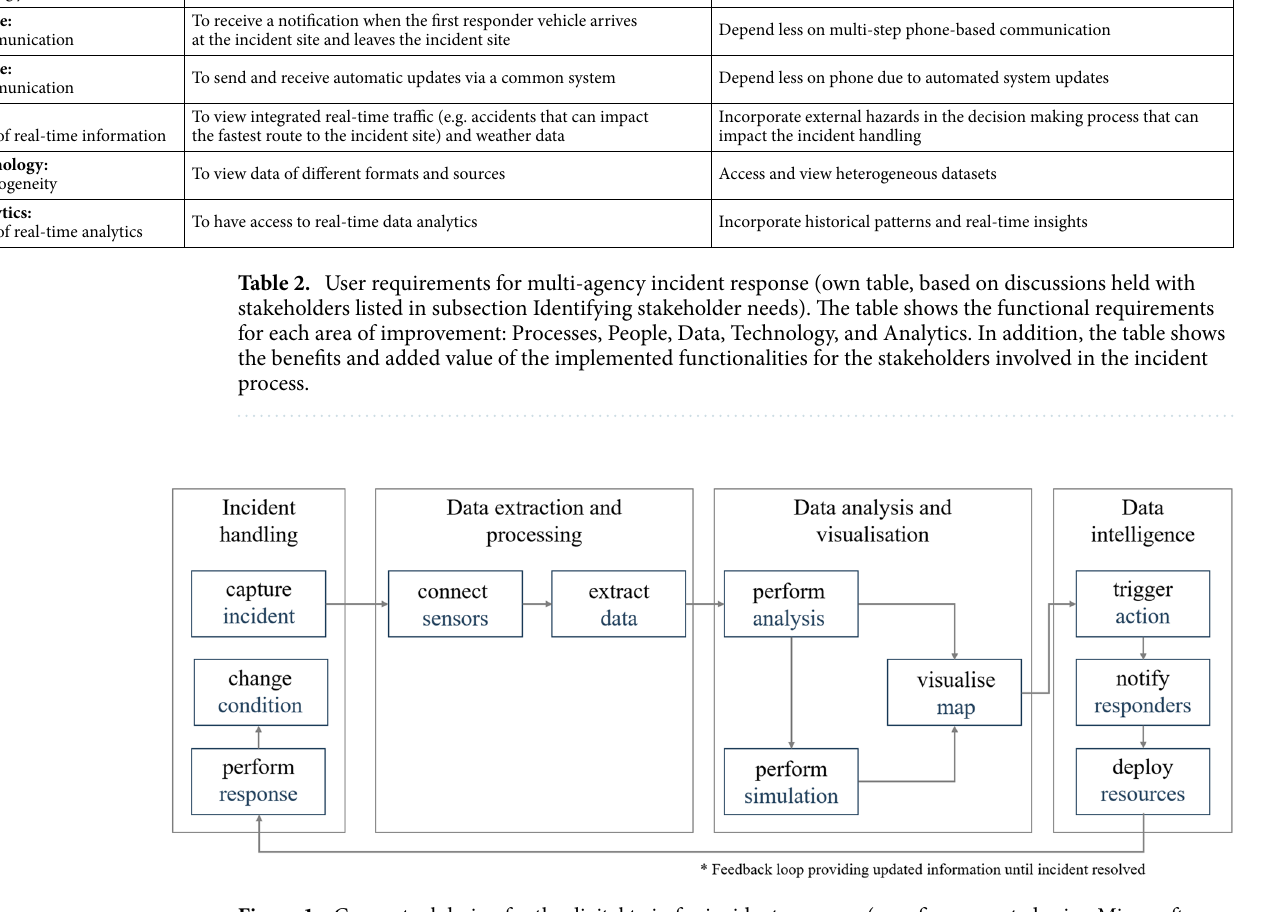
Figure 1. Conceptual design for the digital twin for incident response (own figure created using Microsoft PowerPoint, based on Ford and Wolf 19 ). The design of the customised model includes the stages: Incident handling, data extraction and processing, data analysis and visualisation, and data intelligence. The arrows indicate the sequential flow between different